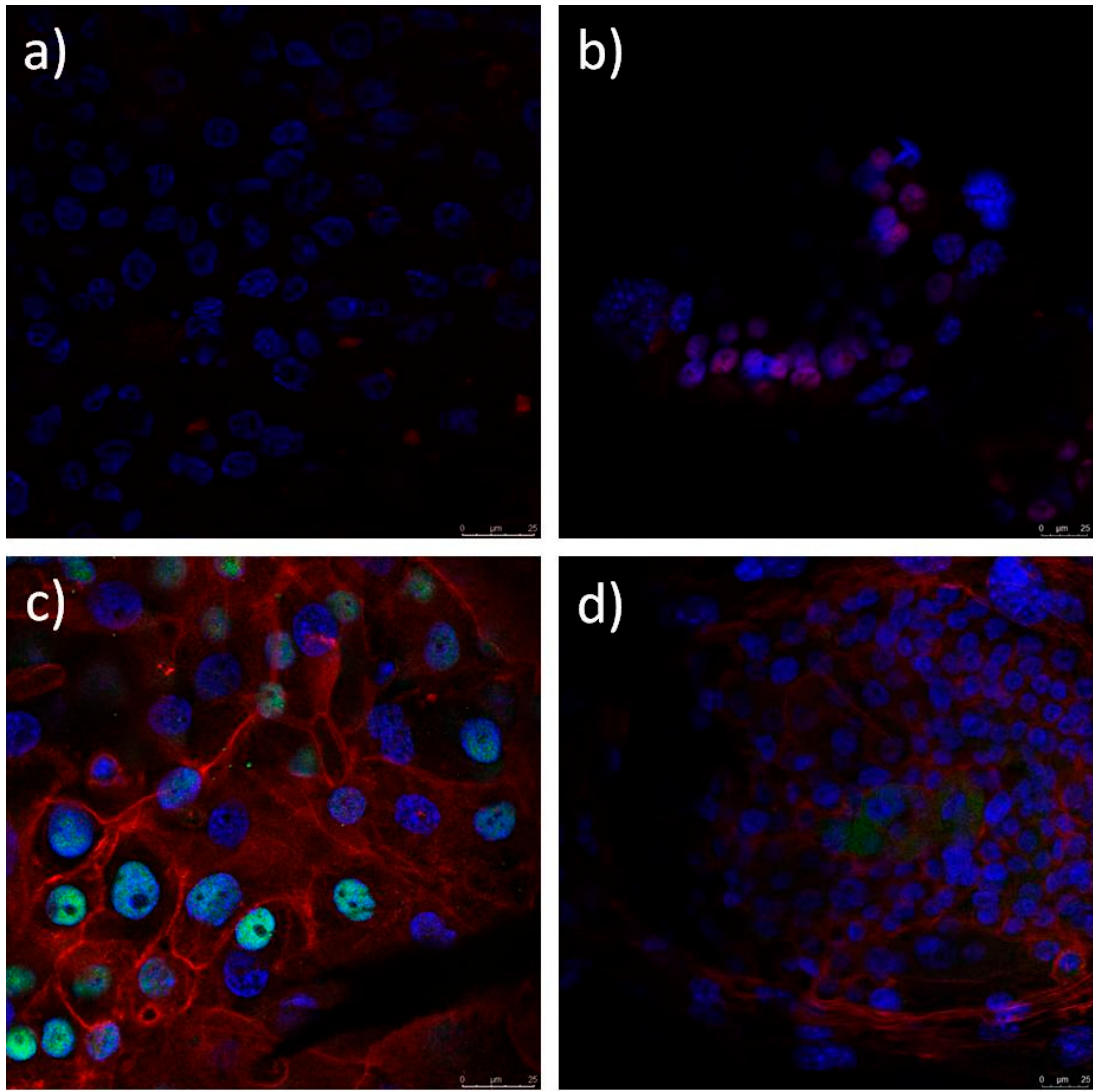
Figure 16. Immunofluorescence analysis of limbal stem cells cultured on PCL scaffold. Cells positive on cornea marker CK3 have cytoplasm coloured red ( a , b ) and cell positive on stem cell marker p63 show nuclei stained with turquoise. Cytoskeleton is stained red with phalloidin- tetramethylrhodamine B isothiocyanate (TRITC) ( c , d ). All nuclei are counterstained with blue stain 4 ′ ,6-diamidino-2-phenylindole (DAPI).